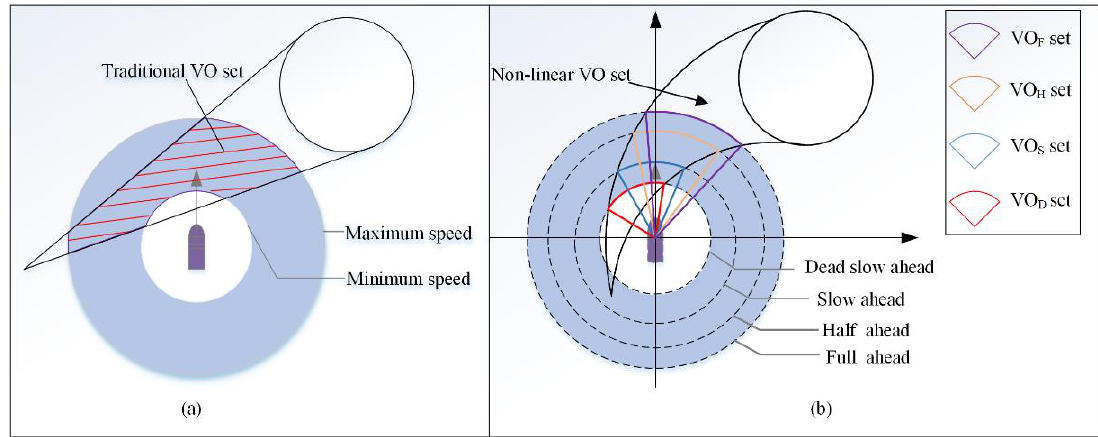
Figure 5. The diagram of the IVO method: ( a ) Traditional VO set; ( b ) Non-linear VO set.